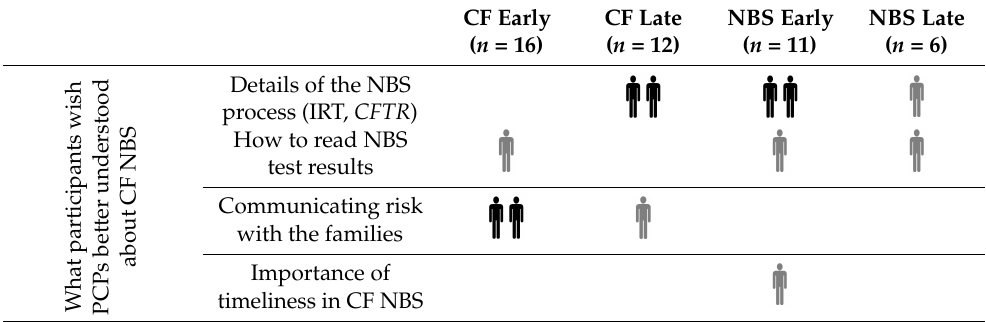
Table 3. Key themes identified listed by analysis groups when interviewees were asked what they wished PCPs better understood about CF; themes identified by at least 30% of the group are represented by one figure; themes identified by at least 60% of the group are represented by two